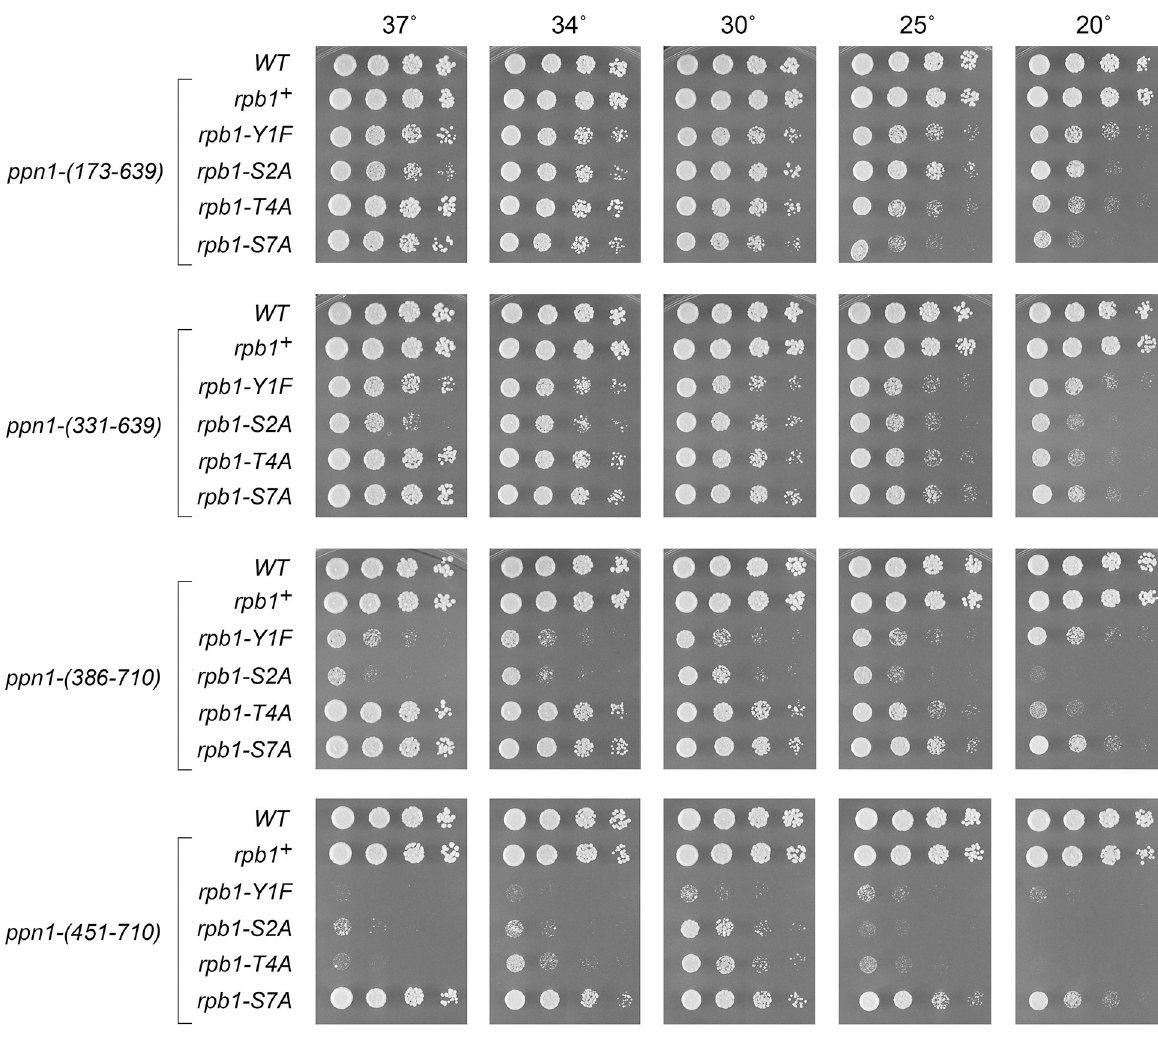
Fig 7. Activity of Ppn1 truncations in CTD mutant backgrounds. Strains with the indicated ppn1 truncation alleles in combination with rpb1-CTD phospho-site mutants were spot-tested for growth on YES agar at the indicated temperatures.